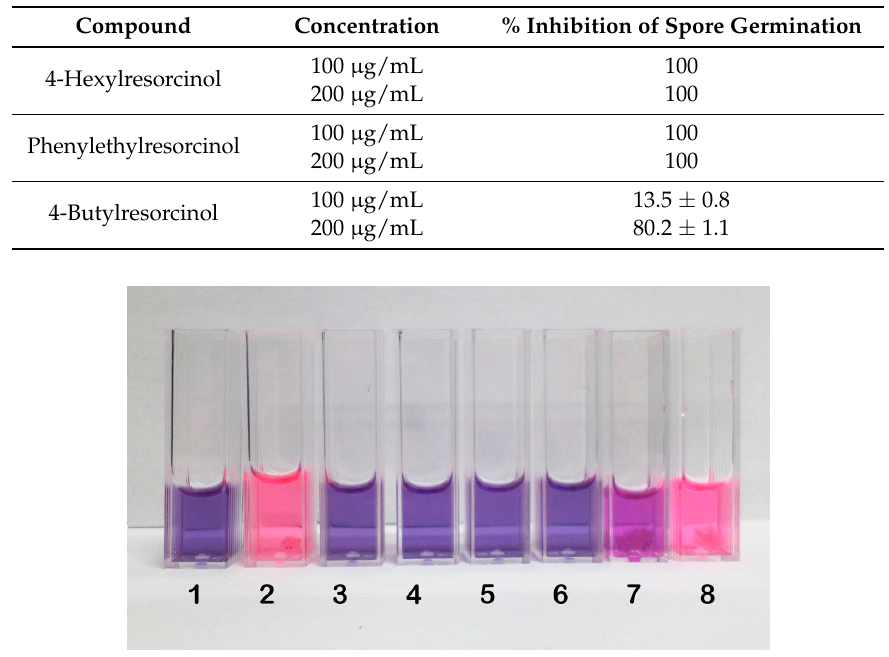
Figure 2. Colours of the cuvettes after the resazurin assay. Legend: 1 —negative control; 2 —positive Colours of the cuvettes after the resazurin